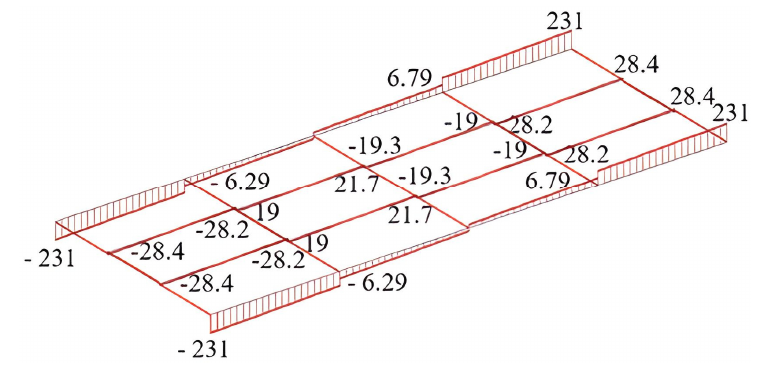
Figure 5. Diagram of the torque moments on the module (kN·m).